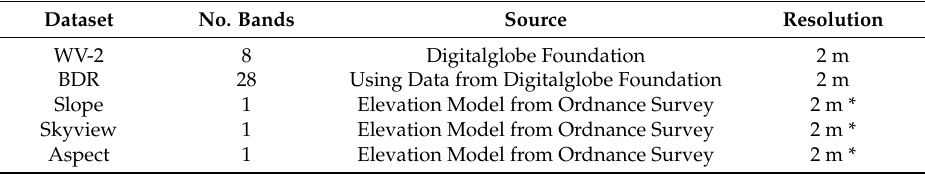
Table 2. Datasets for classification.